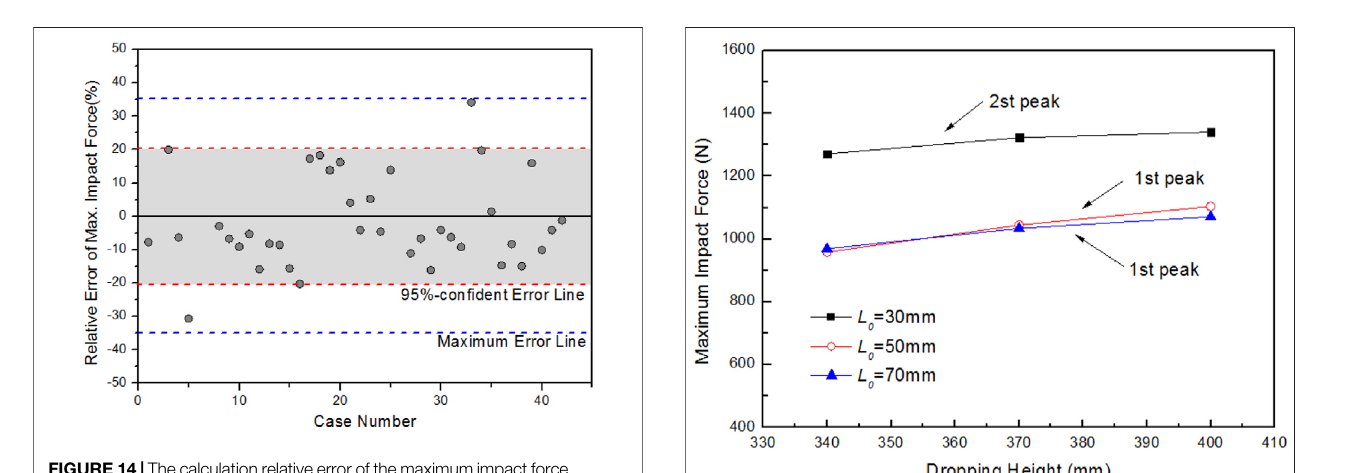
FIGURE 14| The calculation relative error ofthe maximum impact force.